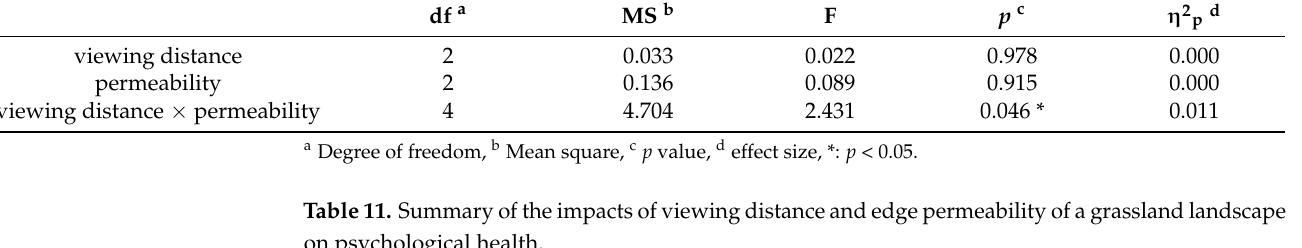
Table 10. Impacts of different viewing distances and permeability levels on (cid:52) E LF/HF. df a MS b F p c η 2 p d